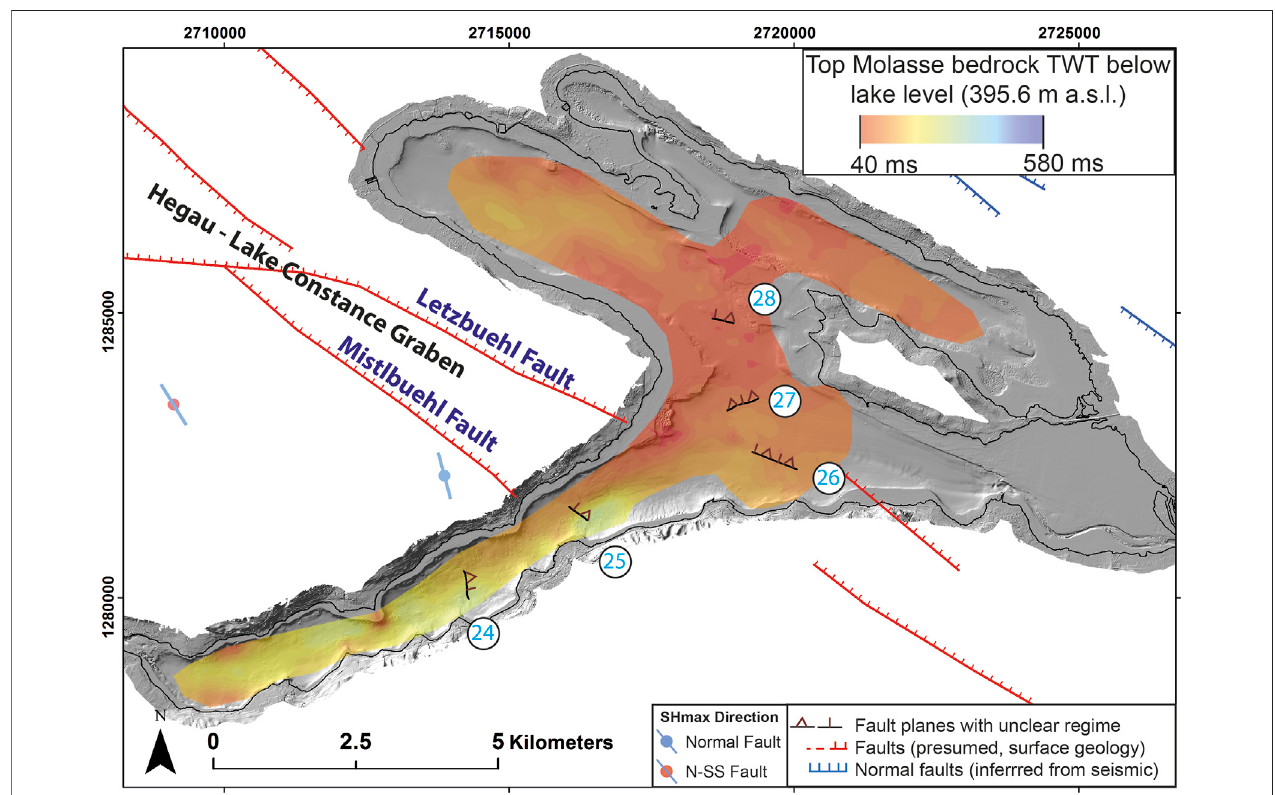
FIGURE 11 | Compilation of fault planes based on seismic data from 2017. The Letzbuehl and Mistlbuehl Fault belong to the Hegau-Lake Constance Graben SystembelongtotheHegau-LakeConstanceGrabenSystem.DipdirectionsforfaultplanesFIDs24 – 28areindicated.FIDs25 – 27alignwellwithonshorefaultsystems. For color-coded con fi dence of faults, see legend in Figure 10